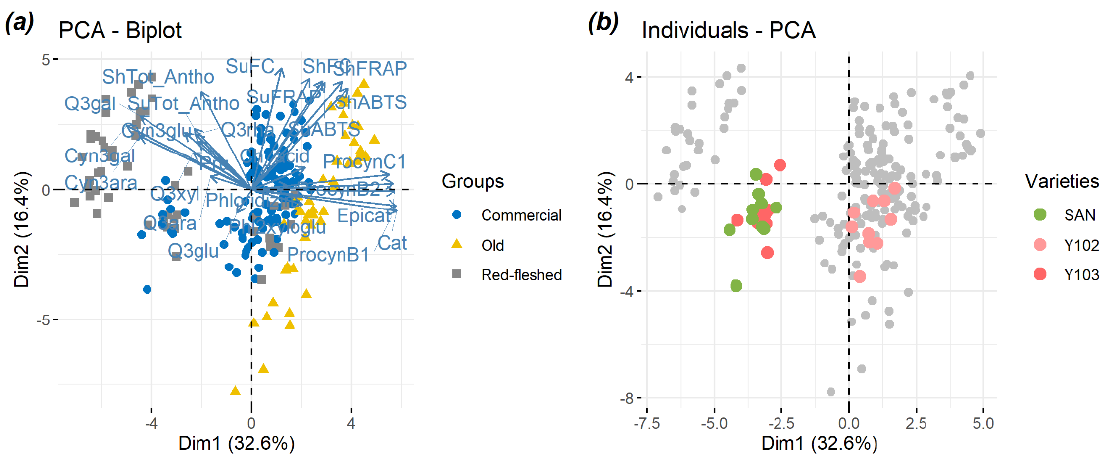
Figure 1. PCA of detected individual polyphenols in the pulp and of the antioxidant activities in the peel of 22 apple varieties. The colors (yellow, blue, and gray) indicate the apple classes (old, commercial, and red-fleshed). Loading is shown ( a ). PCA of the dataset where colors are used to highlight scores for three apple cultivars (one dot per apple shown): SAN, Y103, and Y102. The gray dots represent the other varieties. Scores are shown. ( b ). For apple variety names see Table 1. Table 1. List of cultivars, code of cultivars, variety group, harvest days, storage days, and sampling days of apples analyzed in this study (d = day, CS = cold storage, SL = shelf life).